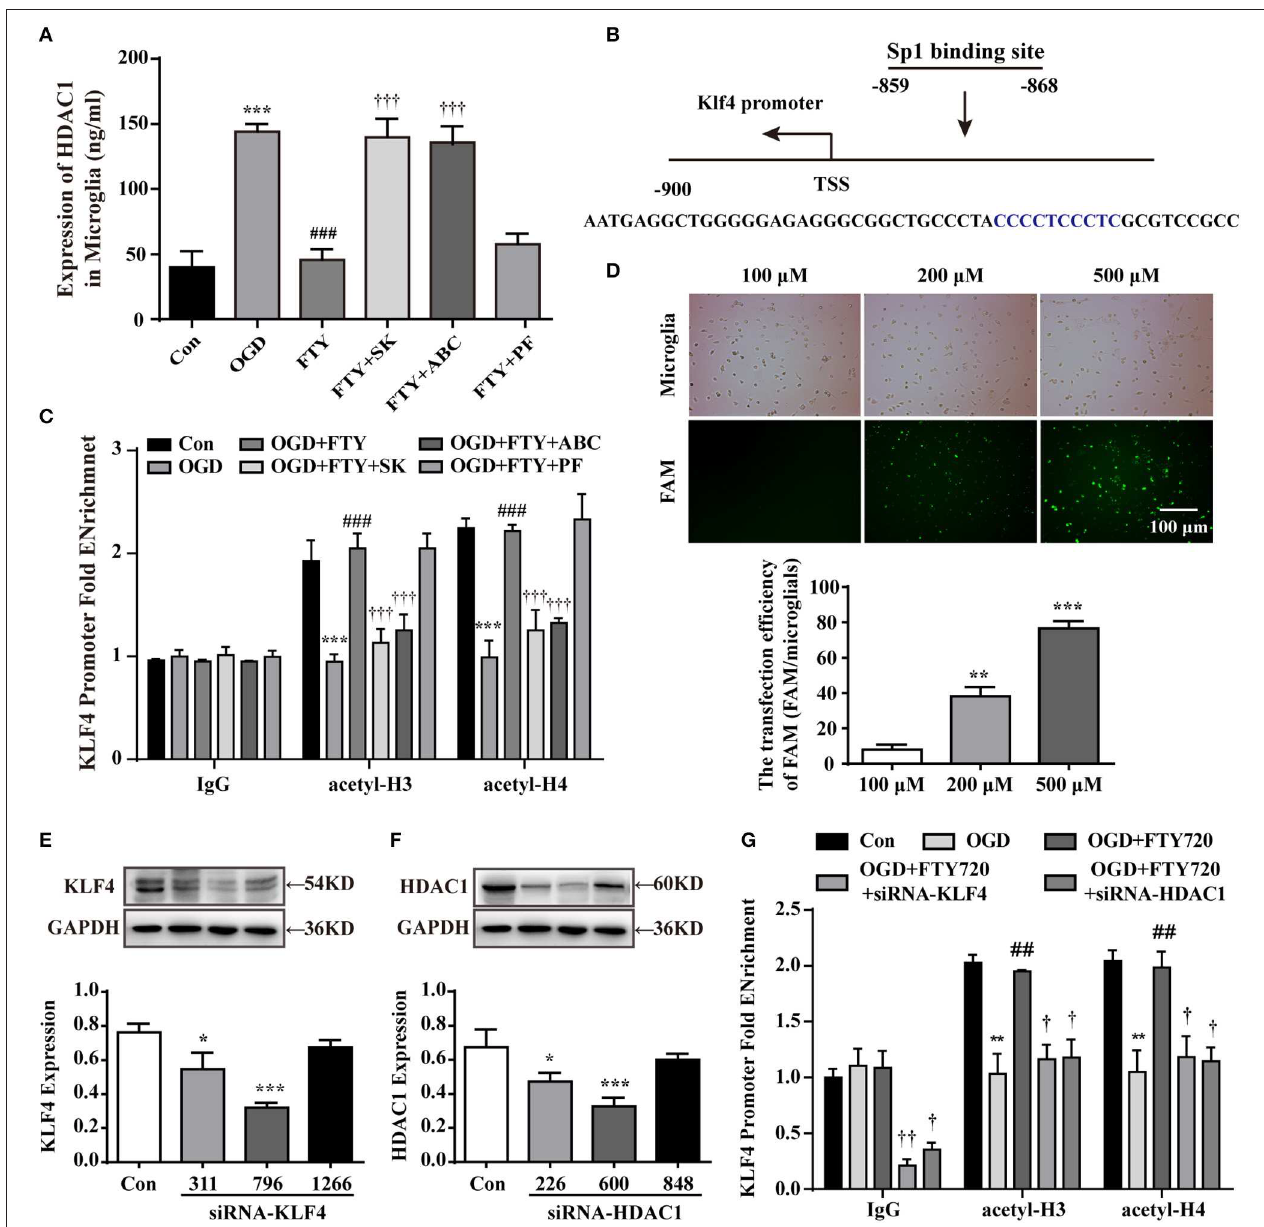
FIGURE 5 | The intra-nuclear SphK2-S1P axis inhibits the HDAC1 expression and deacetylation of KLF4 promoter regions in intra-nuclear. (A) The expression of HDAC1 was analyzed by ELISA. n ≥ 4 per group, *** p < 0.001, compared to the Con group; ### p < 0.001, compared to the OGD group; ††† p < 0.001, compared to the OGD + FTY720 group. (B) Site of KLF4 promoter located between − 859 and − 868 from the transcription starting site. (C,G) ChIP-qPCR assay was used to detect the acetylation levels of histone H3 and H4 at the KLF4 promoter regions. n ≥ 4 per group, ** p < 0.01, *** p < 0.001, compared to the Con group; ## p < 0.01, ### p < 0.001, compared to the OGD group; † p < 0.05, †† p < 0.01, ††† p < 0.001, compared to the OGD + FTY720 group, by one-way ANOVA and Tukey’s test. (D) Labeled (FAM) with green to primary microglia was used to observe the efficiency of transfection. Scale bar = 100 µ m. Quantitation of western blot data showing siRNA-FAM transfection efficiency. Statistical analysis was performed using One-way ANOVA followed by Bonferroni’s post-hoc test. Data are presented as means ± SEMs, n = 3, ** p < 0.01, *** p < 0.001, compared with 100 µ M group. Quantitation of western blot data showed the declines in KLF4 (E) and in HDAC1 (F) . Statistical analysis was performed using One-way ANOVA followed by Bonferroni’s post-hoc test. Data are presented as means ± SEMs, n = 4, * p < 0.05, *** p < 0.001, compared with Con group.